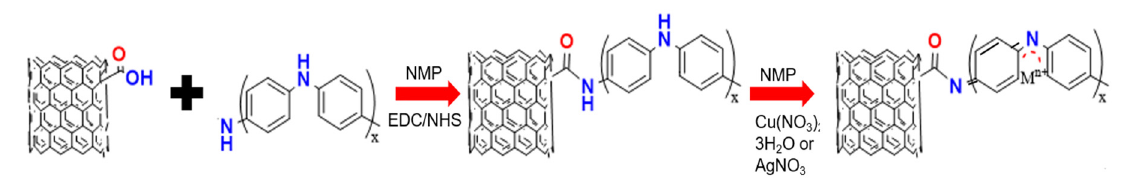
Figure 2. Chemical depiction of the conjugation and doping of MWCNT and